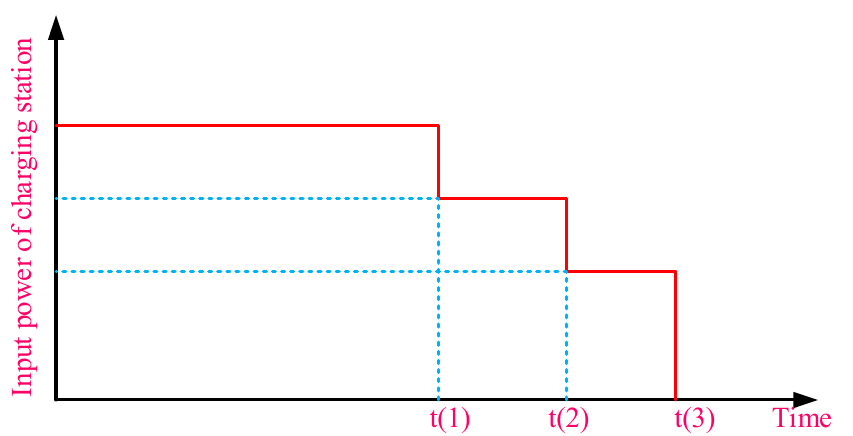
Figure 7. Charging station input/output power modeling.